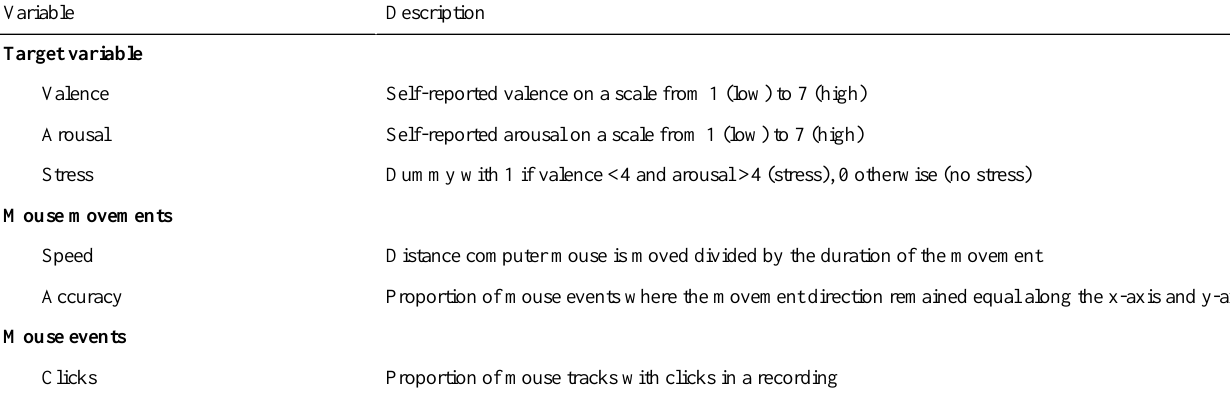
Table 1. Variables and descriptions.